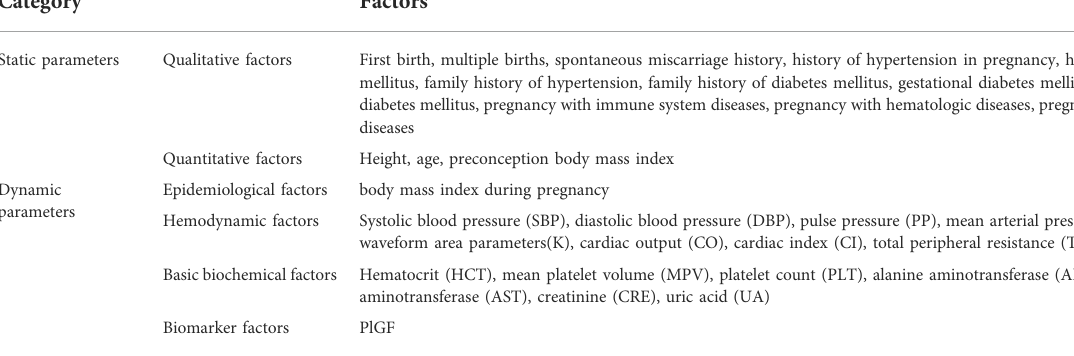
TABLE 1 Classi fi cation of PE risk